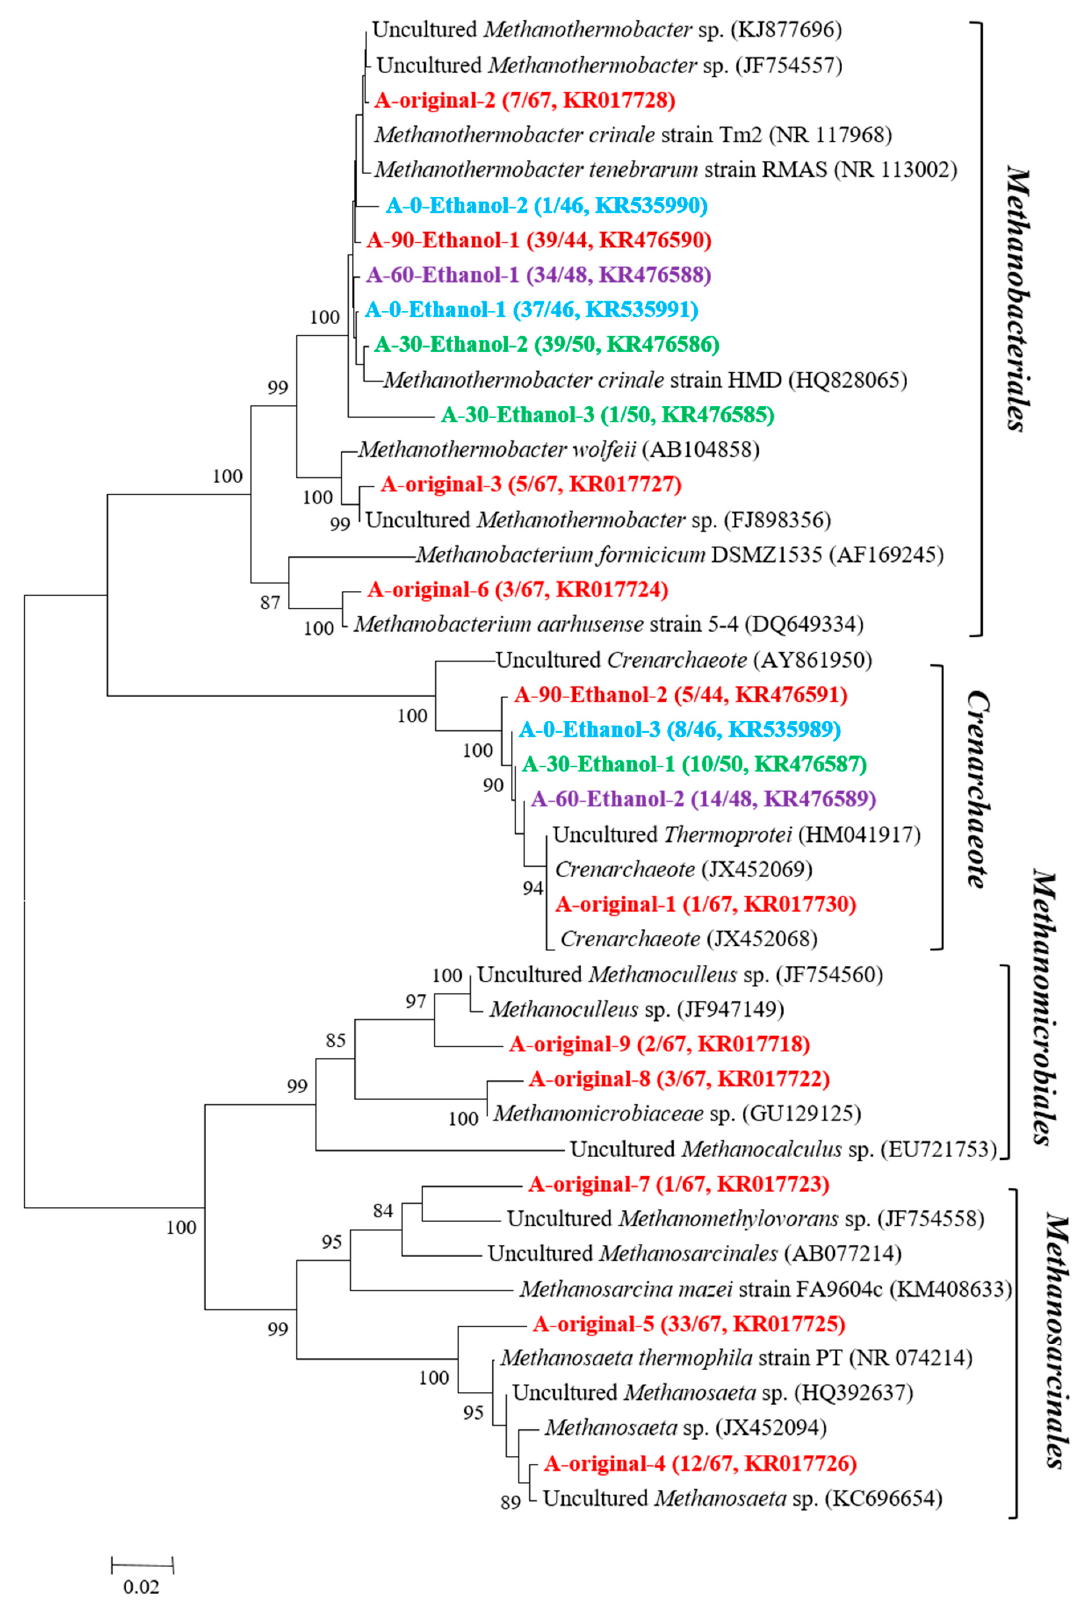
Figure 4. Phylogenic tree of the 16S rRNA gene sequences of Archaea revealed in the clone libraries from different enrichment cultures after anaerobic incubation (indicated by different colors). Scale bars show five (0.02) nucleotide substitutions per 100 nucleotide base pairs. The number in parentheses is the number of